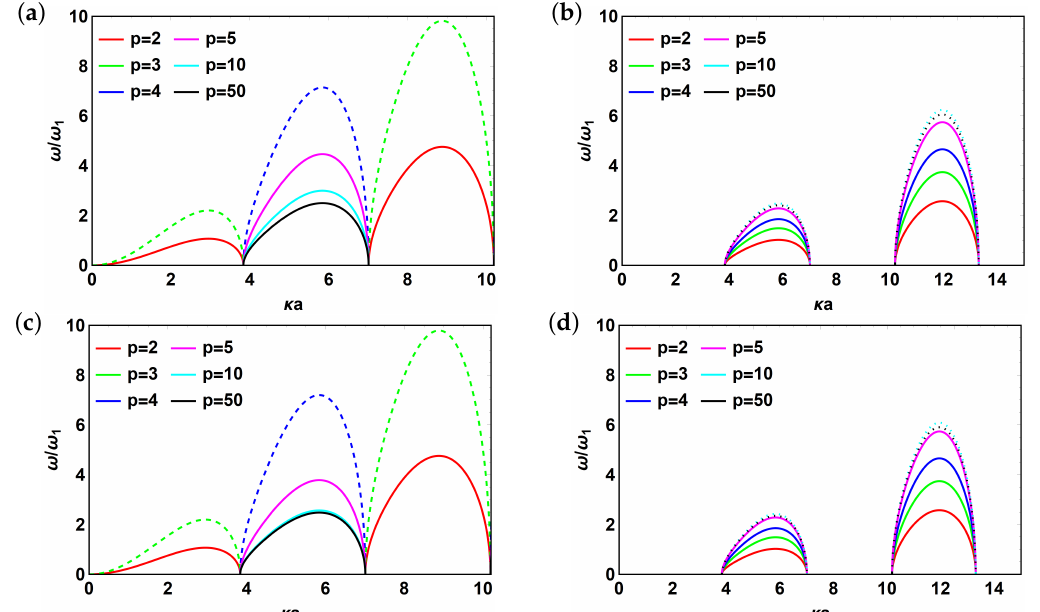
Figure 2. Dispersion relation for metascreen ( a ) w/o interface and w/o reflector; ( b ) w/1 interface and w/o reflector, kh (cid:28) 1, δ (cid:28) 1; ( c ) w/1 interface and w/o reflector, kh (cid:28) 1, “negative” branch; ( d ) w/1 interface and w/o reflector, kh (cid:28) 1, “positive” branch. For all plots n = 1, q = 2. Dashed lines in ( a , c ) are used to demonstrate switching between modes; dotted lines in ( b , d ) demonstrate the largest resonant peak for various configurations of metamaterial and compare it with the case of independent scatterers (black curve).